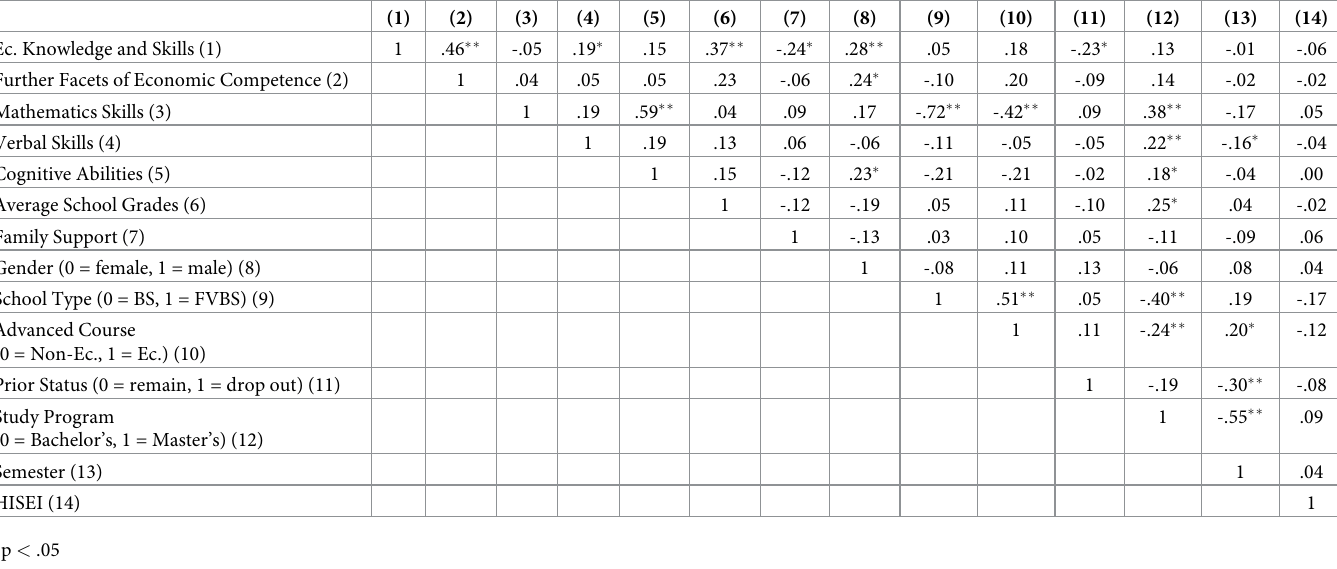
Table 7. Correlations between independent